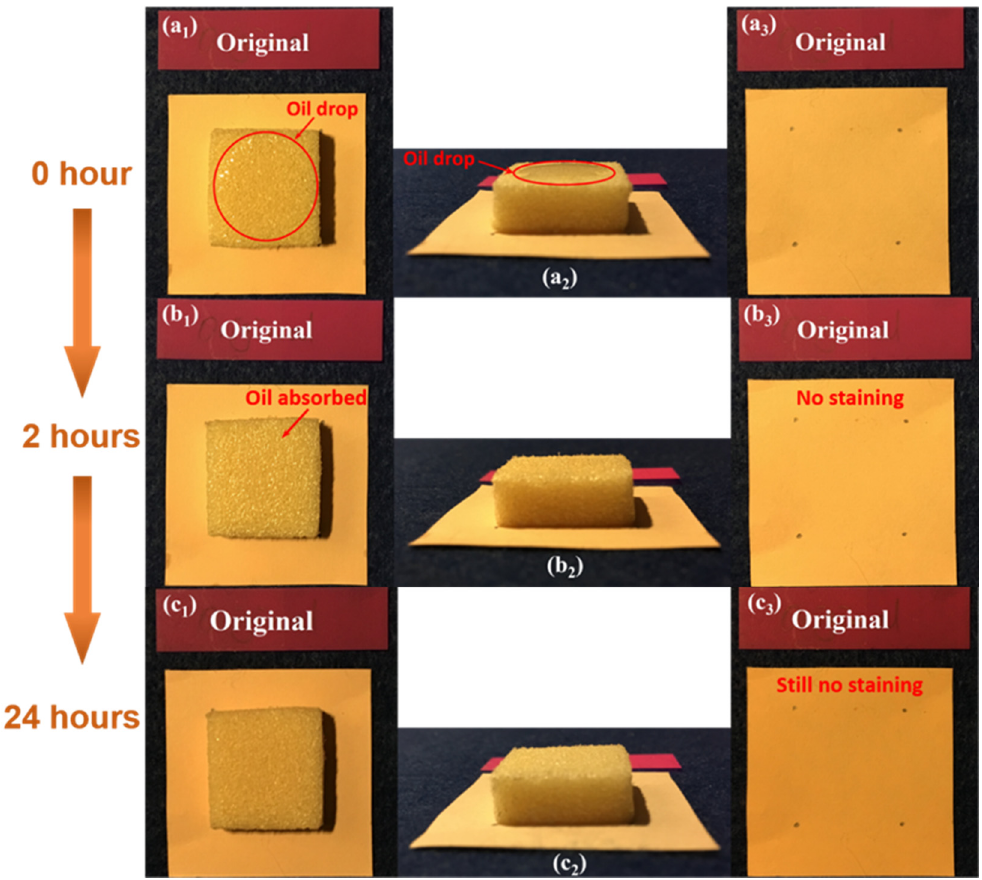
Figure 10. Oil-dripping experiment in an untreated foam sample. ( a 1 ) Top view of sample upon dripping; ( a 2 ) side view of sample upon dripping; ( a 3 ) top view of the paper underneath upon dripping; ( b 1 ) top view of sample after 2 h upon dripping; ( b 2 ) side view of sample after 2 h upon dripping; ( b 3 ) top view of the paper underneath after 2 h upon dripping; ( c 1 ) top view of sample after 24 h upon dripping; ( c 2 ) side view of sample after 24 h upon dripping; ( c 3 ) top view of the paper